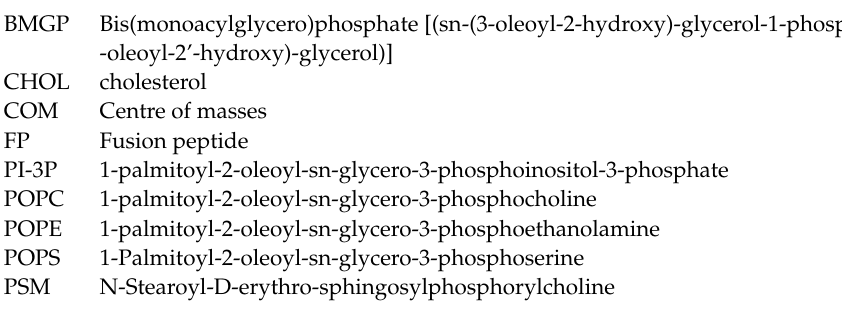
NaCl and CaCl 2 concentration was 0.15 M. Membrane thickness at the end of the MS simulation is also shown. The MD production trajectories for each one of the systems were computed for 450 ns; Table S3: Systems and components used in the third step of this study (FP peptides in the presence of a biological model membrane). The NaCl concentration was 0.15 M. Membrane thickness at the end of the simulation is also shown. The MD production trajectories for each one of the systems were computed for 800 ns; Table S4: Number of contacts and hydrogen bonds between the FPs with the lipids for the selected membrane systems (rounded to the whole number, two FP ´ s per system). The data represent the average of the last 20 ns of the MD simulation; Table S5: Number of lipids around the FP up to 5 Å and contacts between the FPs and lipids. The data represent the average for the three systems and for the last 30 ns of the MD